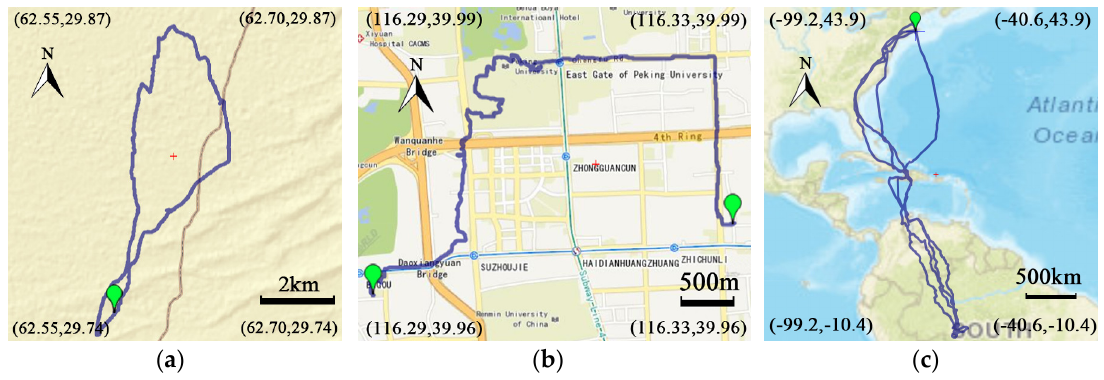
Figure 13. ( a ) Mopsi: A jogging track in a park in Helsinki, Finland. ( b ) Geolife: A track of a student traveling from home to school in Beijing, China. ( c ) Movebank: A three-year track (January 2006~December 2008) of an osprey migrating from the United States to Brazil.